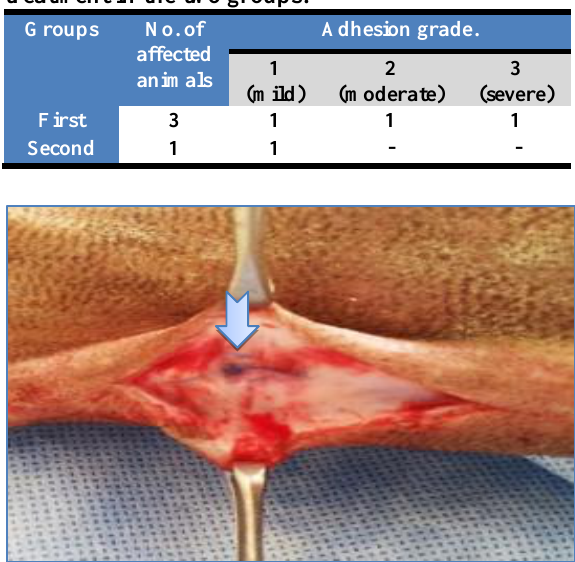
Figure, 5: Shows the adhesion in first group, 2 months post-suturing.